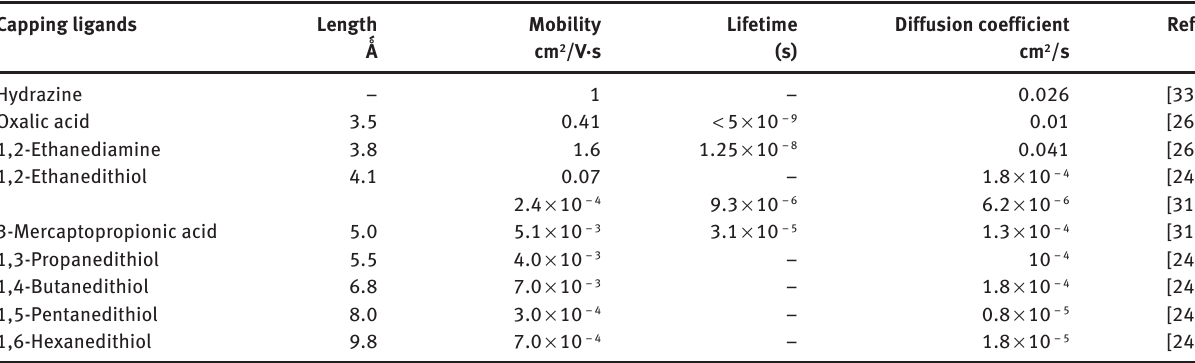
Table 1: Properties of ligands.